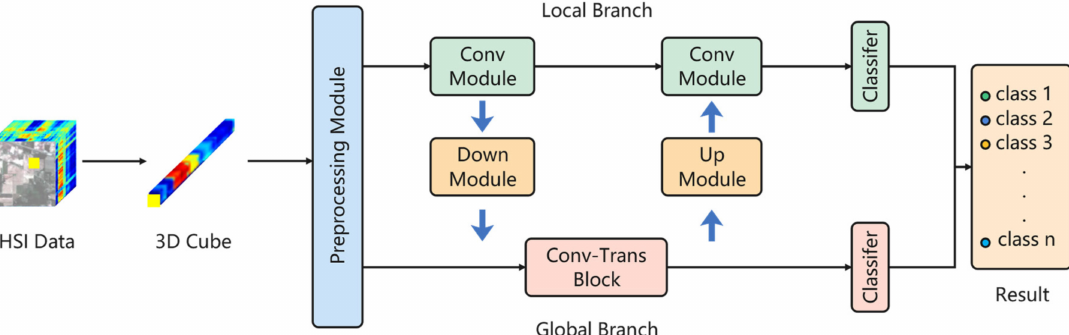
Figure 4. Overall structure of the proposed FusionNet